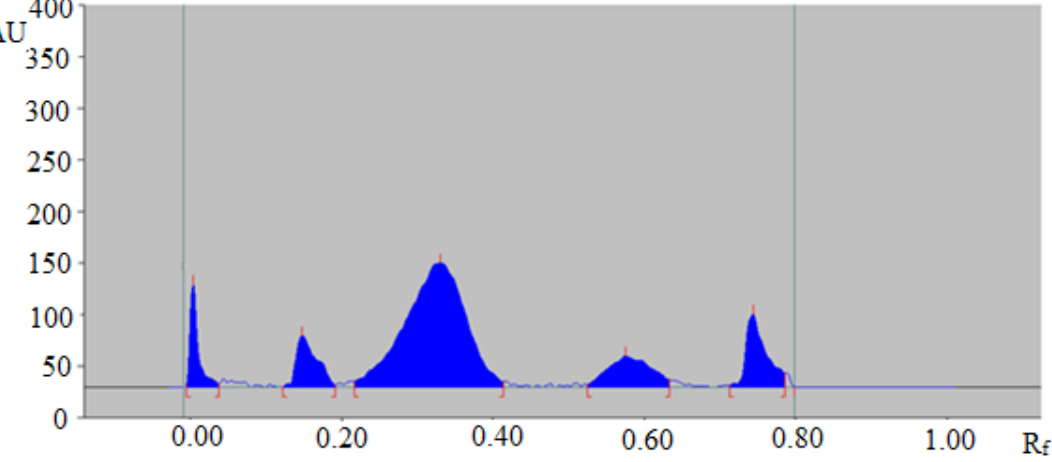
Figure 4. HPTLC chromatogram of TAL in the essential oil of Foeniculum vulgare .